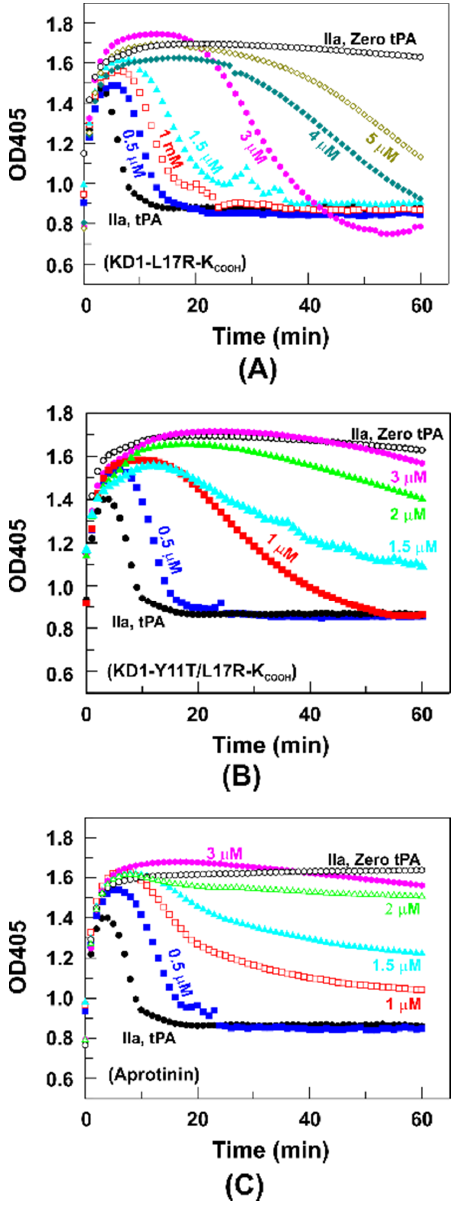
Figure 5. Effect of KD1-L17R-K COOH , KD1-Y11T/L17R-K COOH and aprotinin on fibrinolysis in human